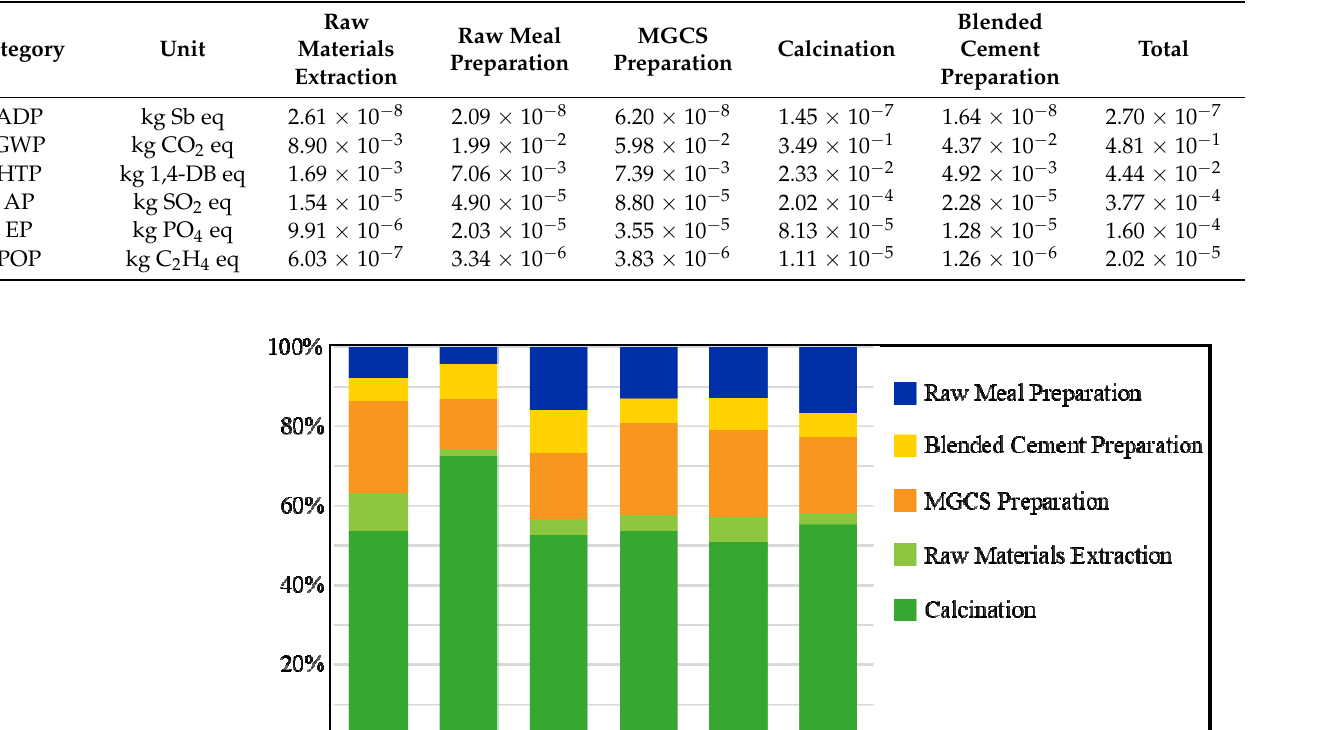
Table 2. Contribution of each stage on selected impact categories (Characterization).